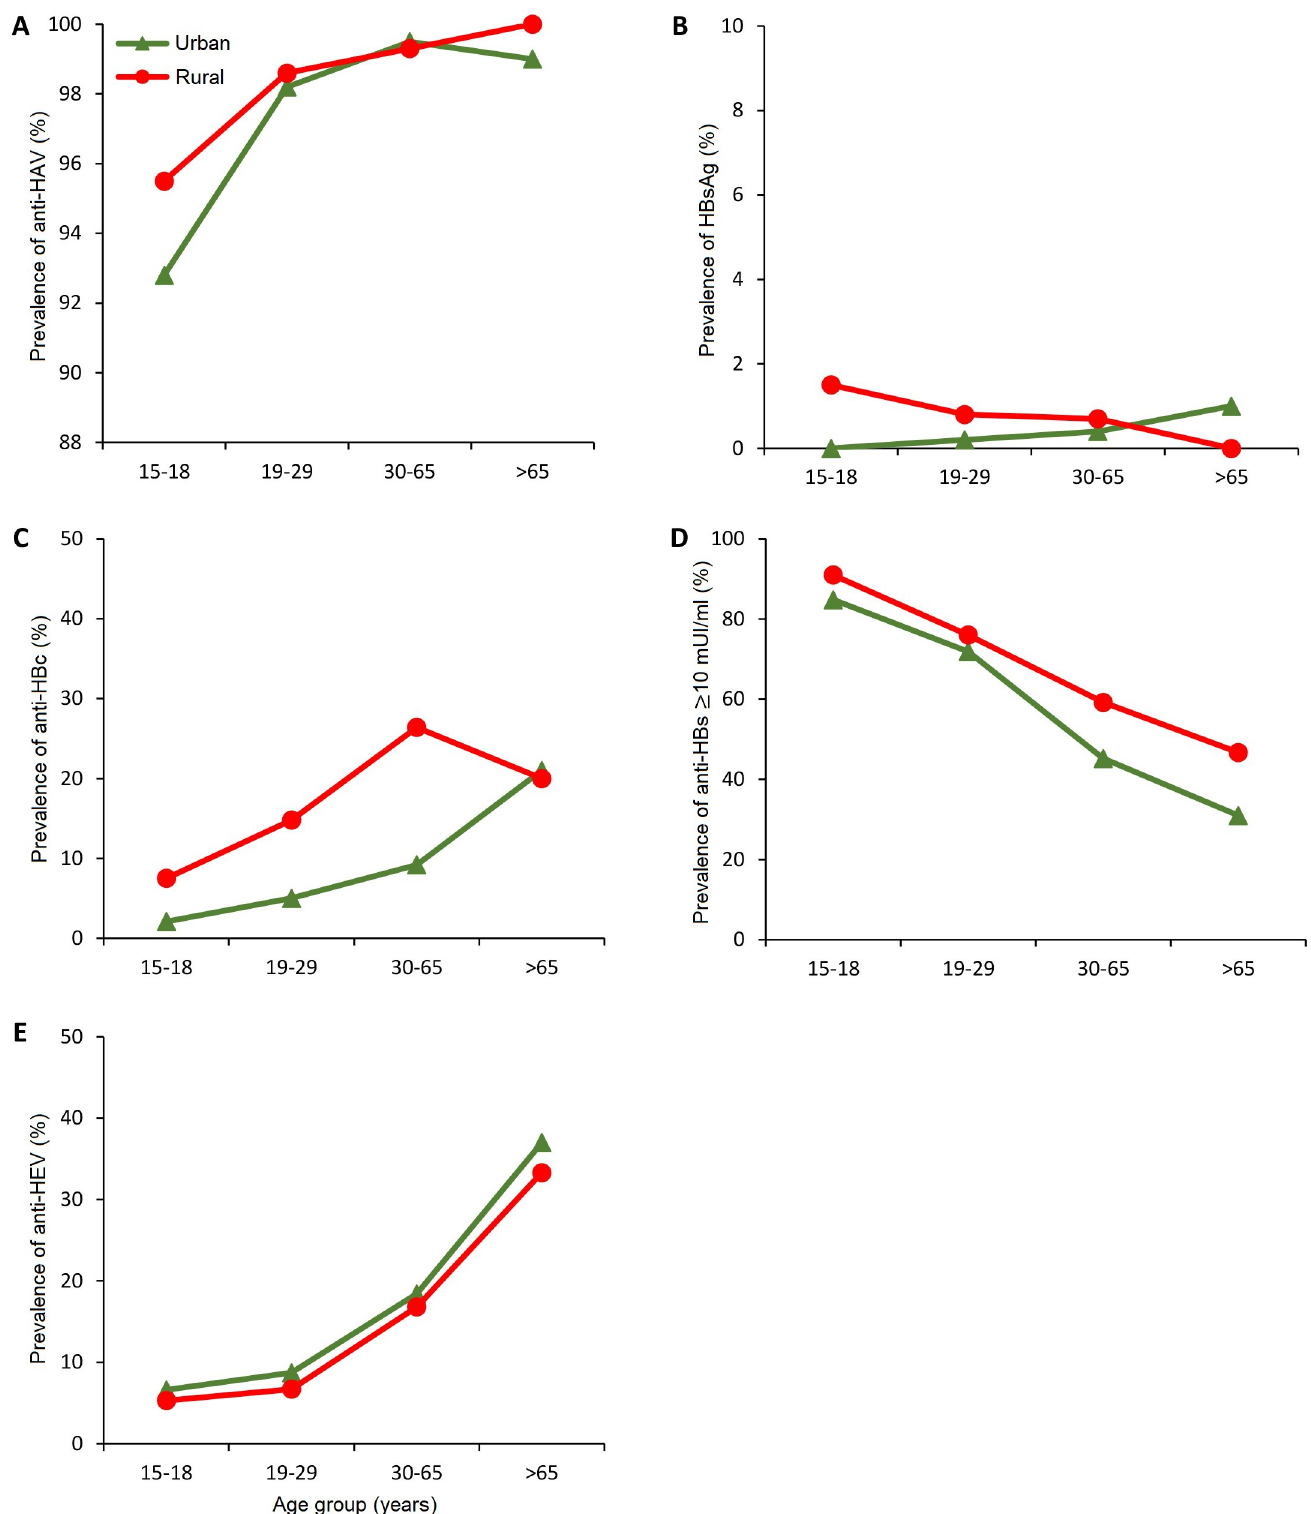
Fig 2. Prevalence rates of anti-HAV IgG (A), HBsAg (B), anti-HBc IgG (C), anti-HBs � 10 mUI/ml (D) and anti-HEV IgG (E) by age groups in urban and rural areas of Peru.